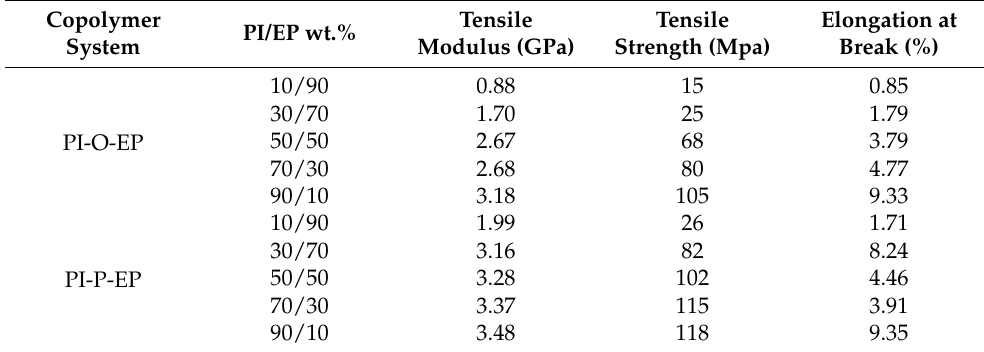
Table 2. Results of mechanical tests for PI-EP films.